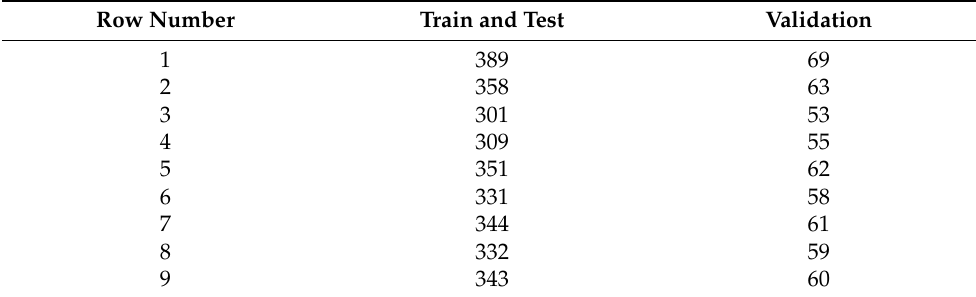
Table 1. Amount of data used for training, testing, and validation of the models in this study. Row Number